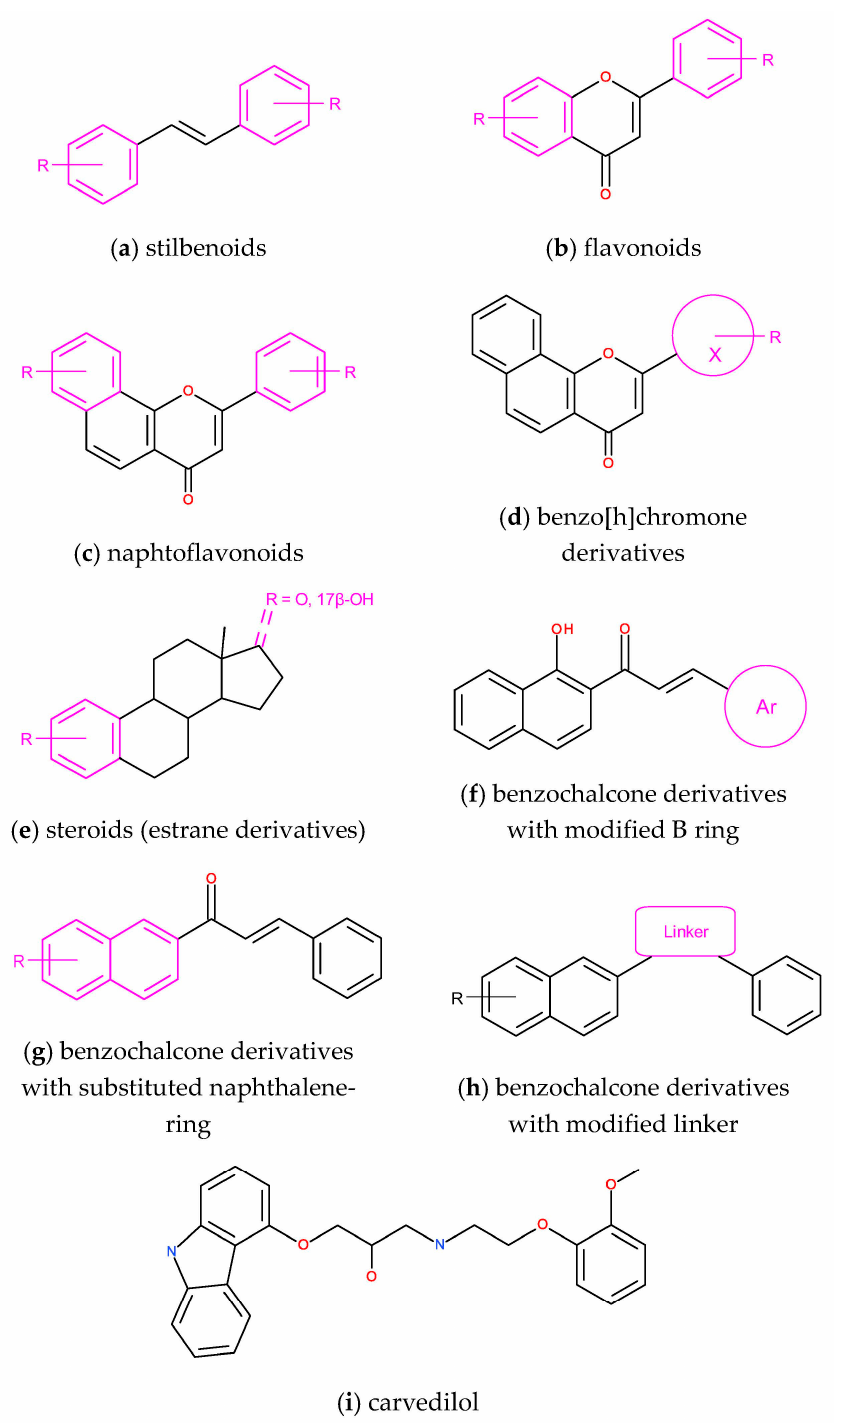
Figure 6. Core structures (scaffolds) used in the design of selective CYP1B1 inhibitors: ( a ) trans -stilbene derivatives; ( b ) flavone derivatives substituted in A and B rings, ( c ) α -naphtoflavone derivatives with B and D ring modifications; ( d ) benzo[h]chromone derivatives with various B-ring (X) structures; ( e ) pyridine-, 3-thio- and 2-aryl-estrane derivatives; ( f ) benzochalcone derivatives with modified B ring; ( g ) naphthalene ring-substituted benzochalcones; ( h ) linker modified benzochalcones; ( i ) carvedilol as a novel CYP1B1 inhibitor found in structure-based virtual screening. More recently, the selectivity of stilbenoid inhibitors against CYP1 isoforms was studied with integrated fit docking and molecular dynamics simulation. The